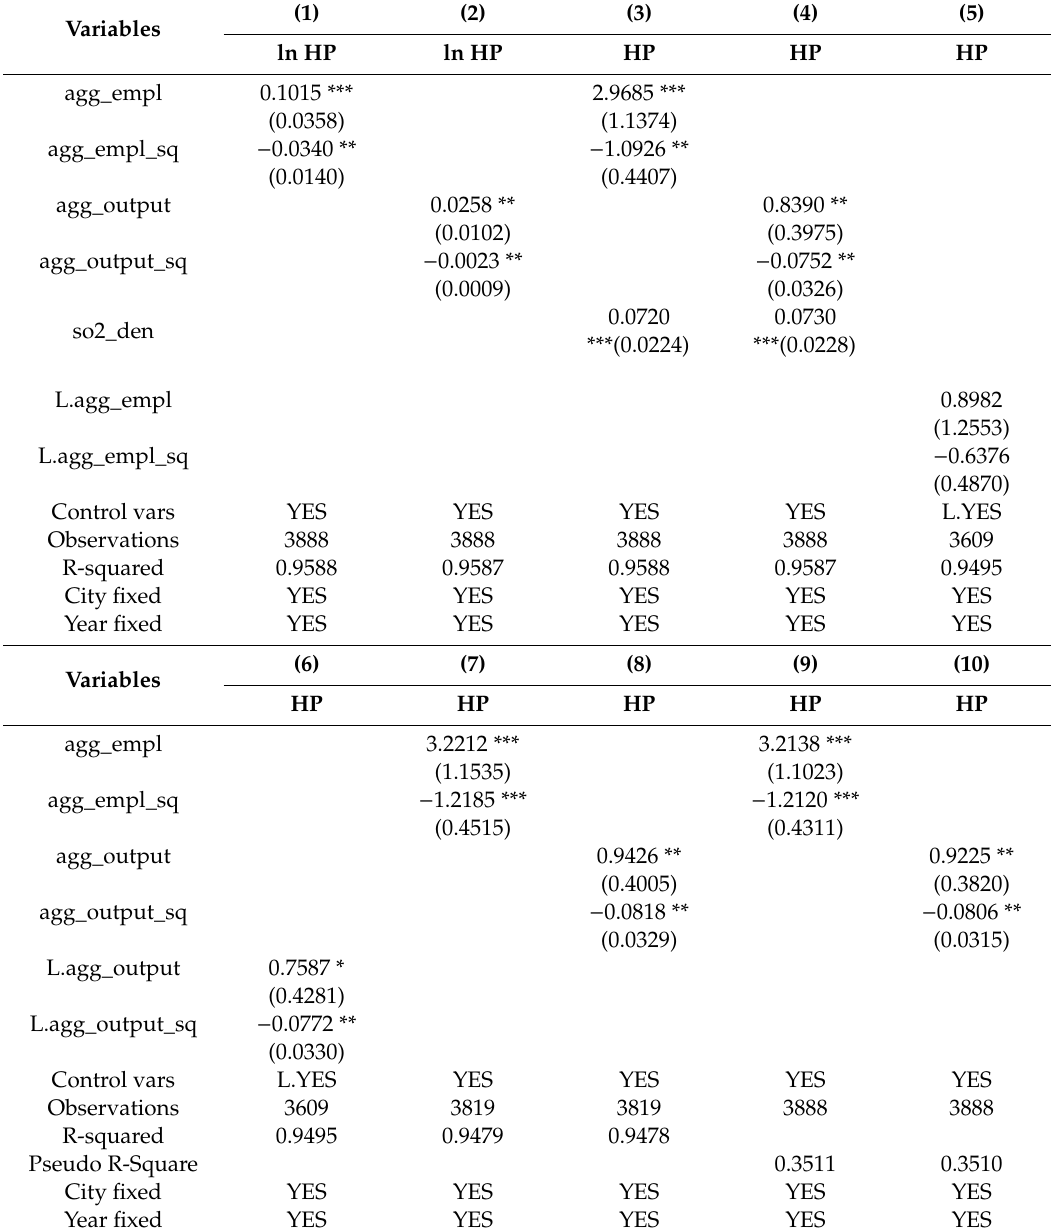
Table 3. Robustness